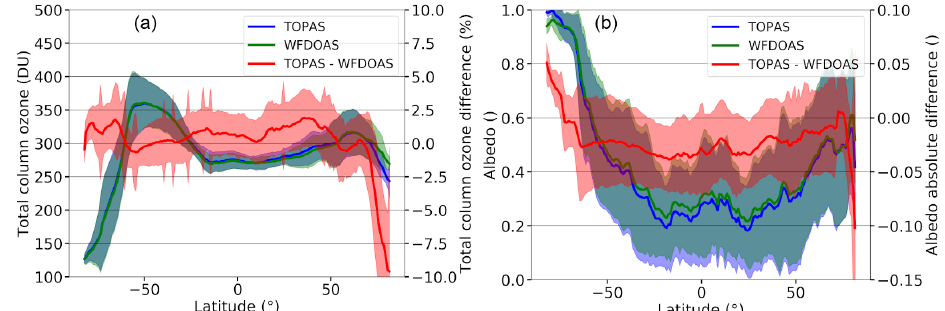
Figure 13. Comparison of the TROPOMI total ozone (a) and albedo (b) resulting from the TOPAS ozone profile retrieval and the WFDOAS total ozone product. The data were averaged over all orbits from 1 October 2018. The retrieval results are displayed in blue (TOPAS total ozone) and green (TROPOMI WFDOAS total ozone). Shaded areas mark the standard deviations of the means. The mean difference and the associated standard deviation are plotted in red. Both albedo and total column from TROPOMI WFDOAS are used as a priori assumptions in the TOPAS ozone profile